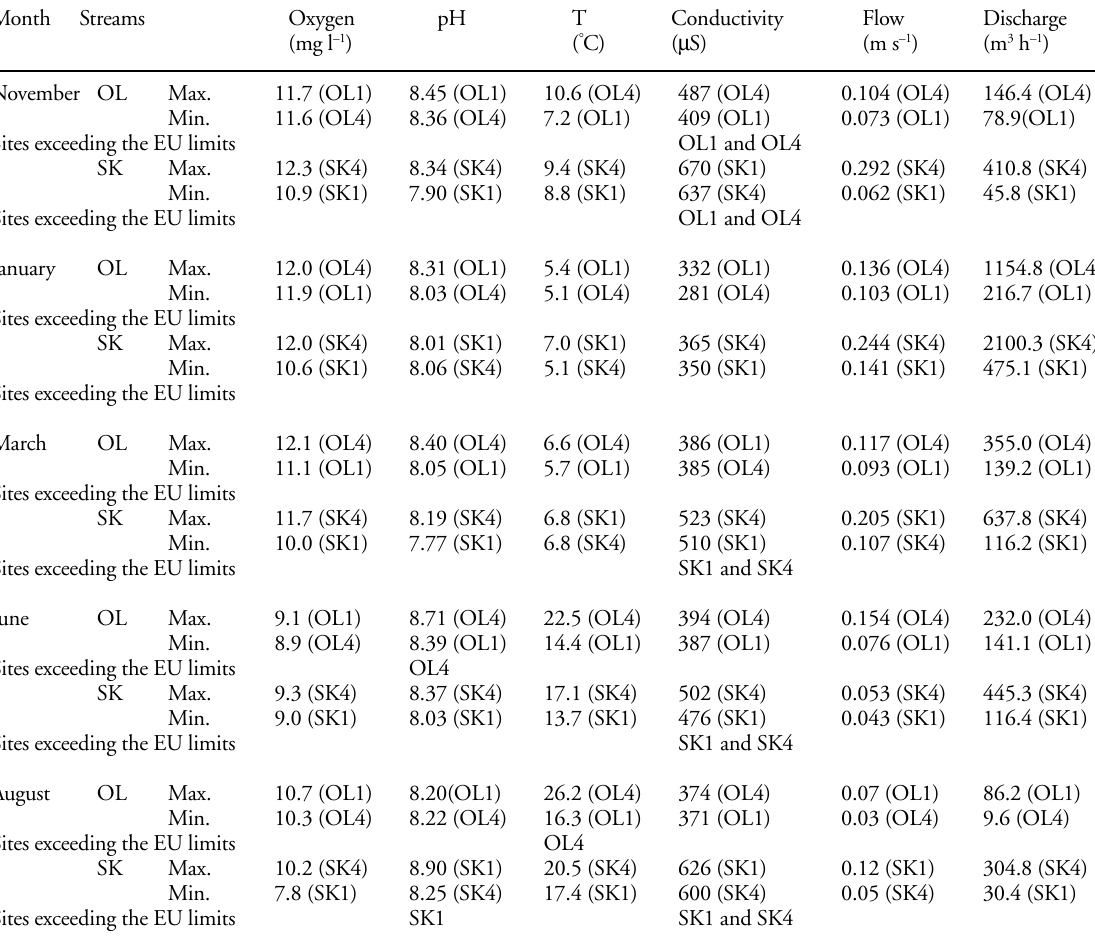
Table 7. Physicochemical parameters of sampling stations at Olympias (OL) and Skouries (SK)